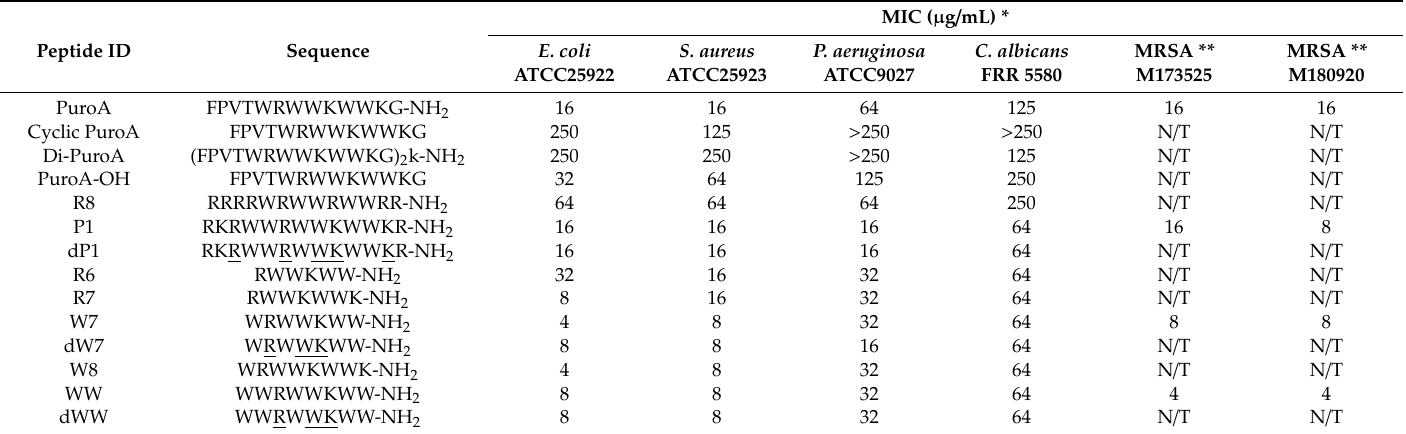
Table 2. Antimicrobial activities of